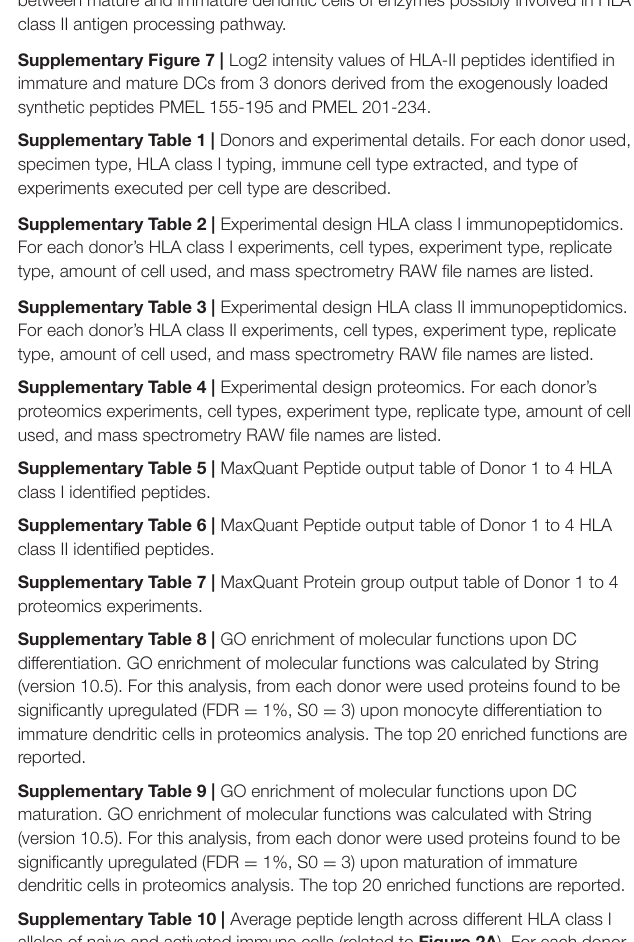
Supplementary Table 11 | HLA class I peptides from synthetic peptides from Donor 5 to 7. Supplementary Table 12 | HLA class II peptides from synthetic peptides from Donor 5 to